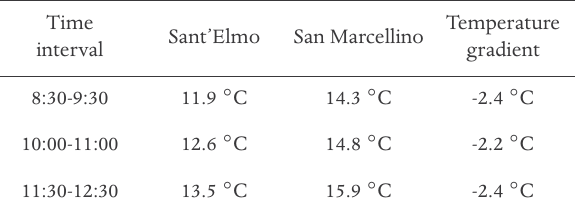
Table 2. Air temperature gradient between Sant’Elmo and San Mar- cellino Meteorological Observatories. The data from Sant’Elmo were taken from